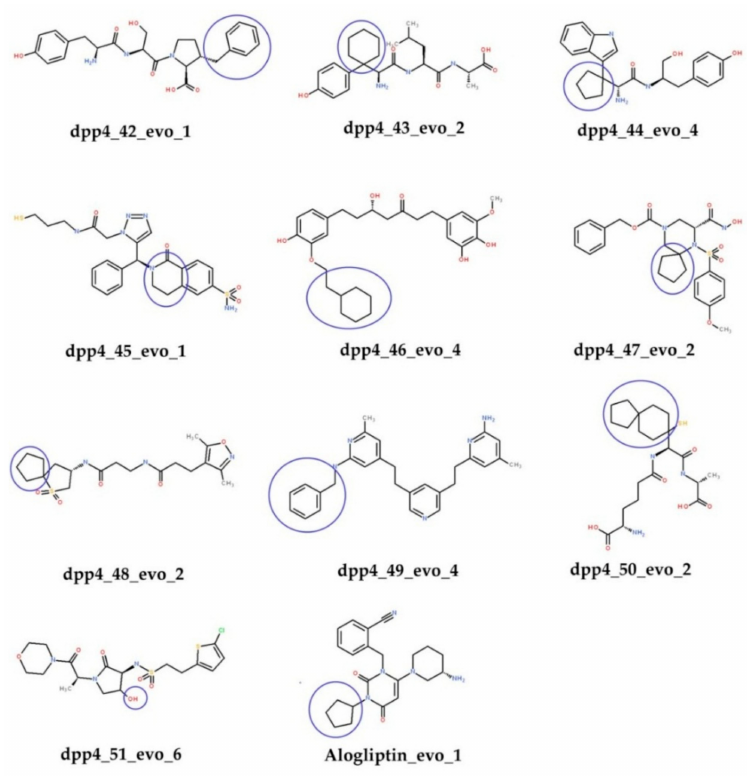
Figure 4. Structures of the derivatives selected after de novo Evolution and Molecular docking. The functional groups added in de novo Evolution are circled in blue.